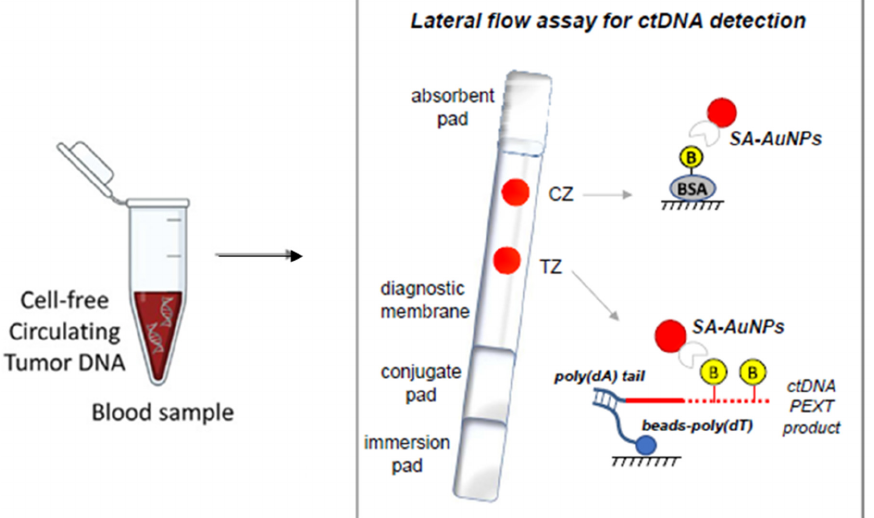
Figure 2. AuNPs-based NABLFA for rapid detection of ctDNA in CRC blood samples. Adapted with permission from [103]. 2021, Elsevier.